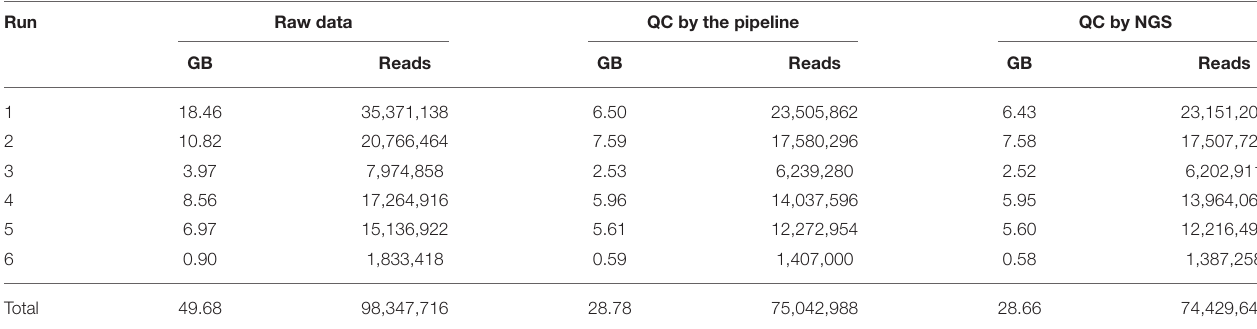
TABLE 5 | Information of the DSL metagenomic data